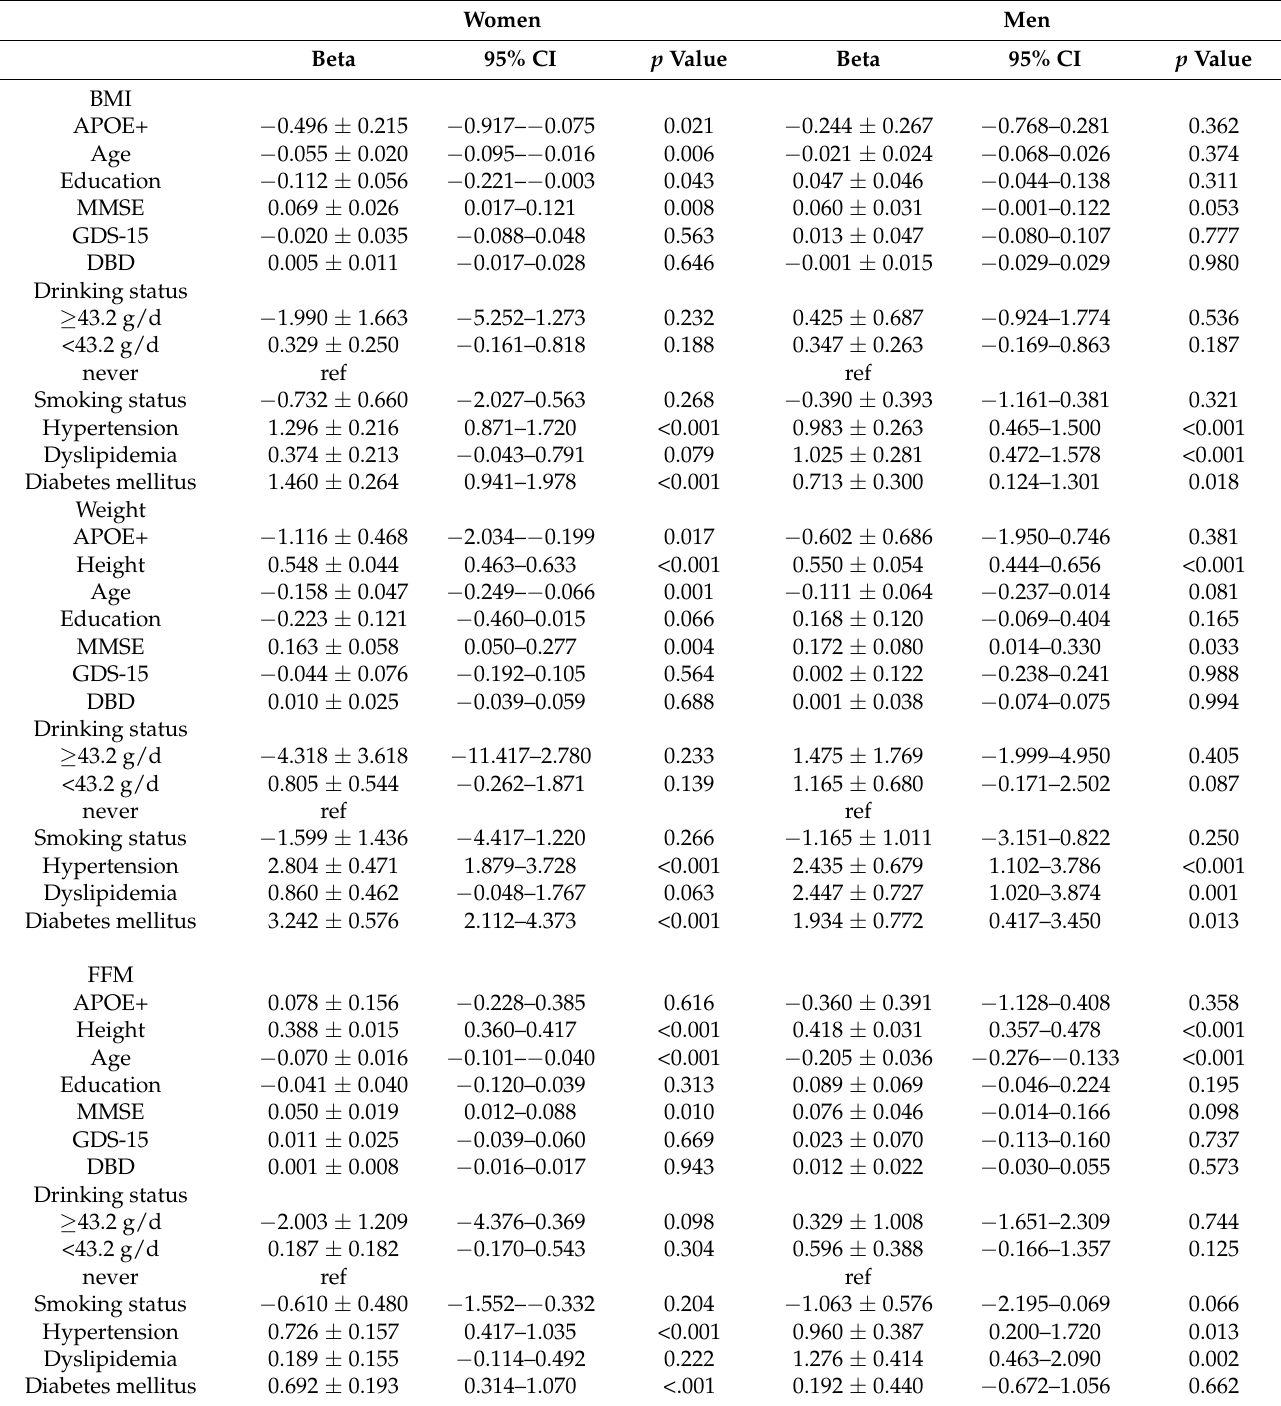
Table 2. Association of each potential predictive variable with body mass index and body